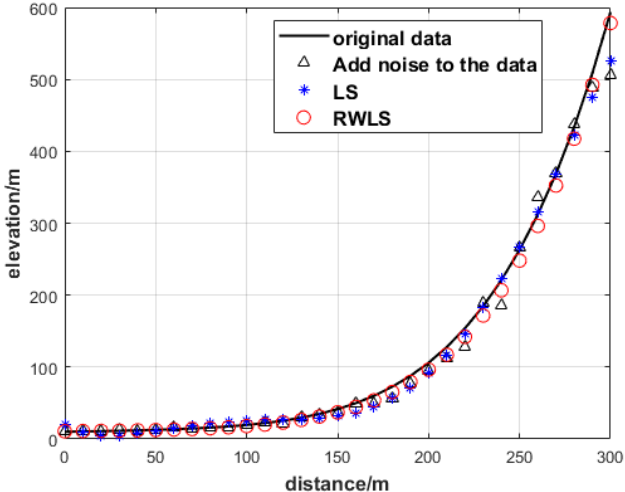
Figure 15. GNSS elevation obtained by the RWLS method and LS.